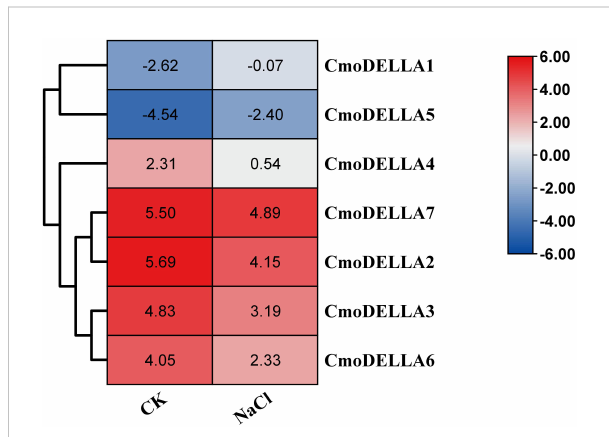
FIGURE 8 Transcriptional pro fi les of CmoDELLA genes under NaCl stress after 24 h. The transcriptional levels are normalized by RPKM method. The red color represents the higher expression, while the blue color indicates the lower expression.